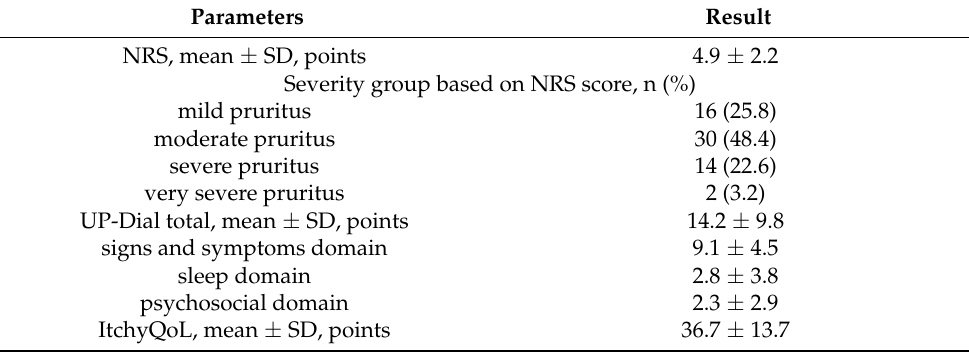
Table 3. Data on the severity of pruritus and quality of life in patients with